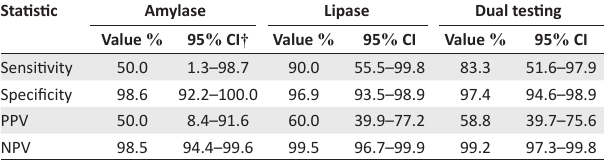
TABLE 2: Sensitivity, specificity, positive predictive value, negative predictive value and respective 95 % confidence interval for amylase, lipase and dual testing for acute pancreatitis at Tygerberg Hospital, 1–31 December 2018. Statistic Amylase Lipase Sensitivity 50.0